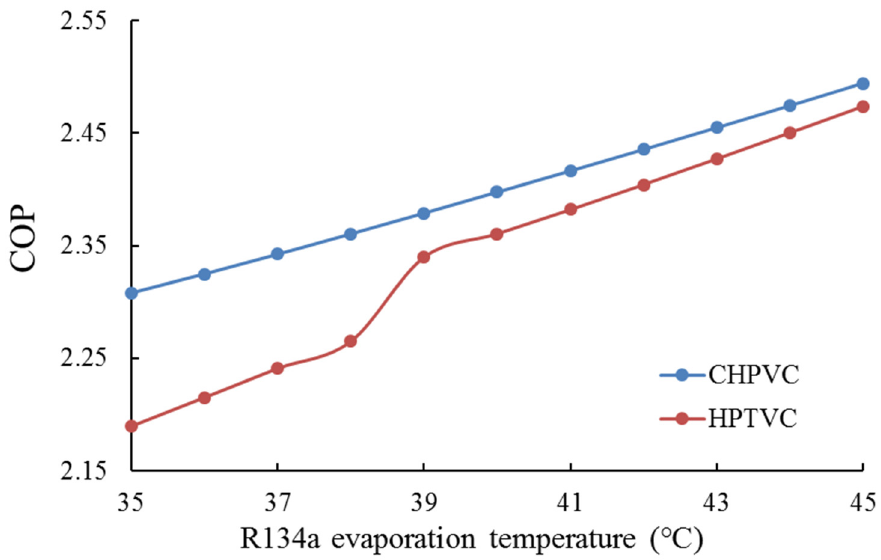
Figure 4. COP versus the R134a evaporation temperature.